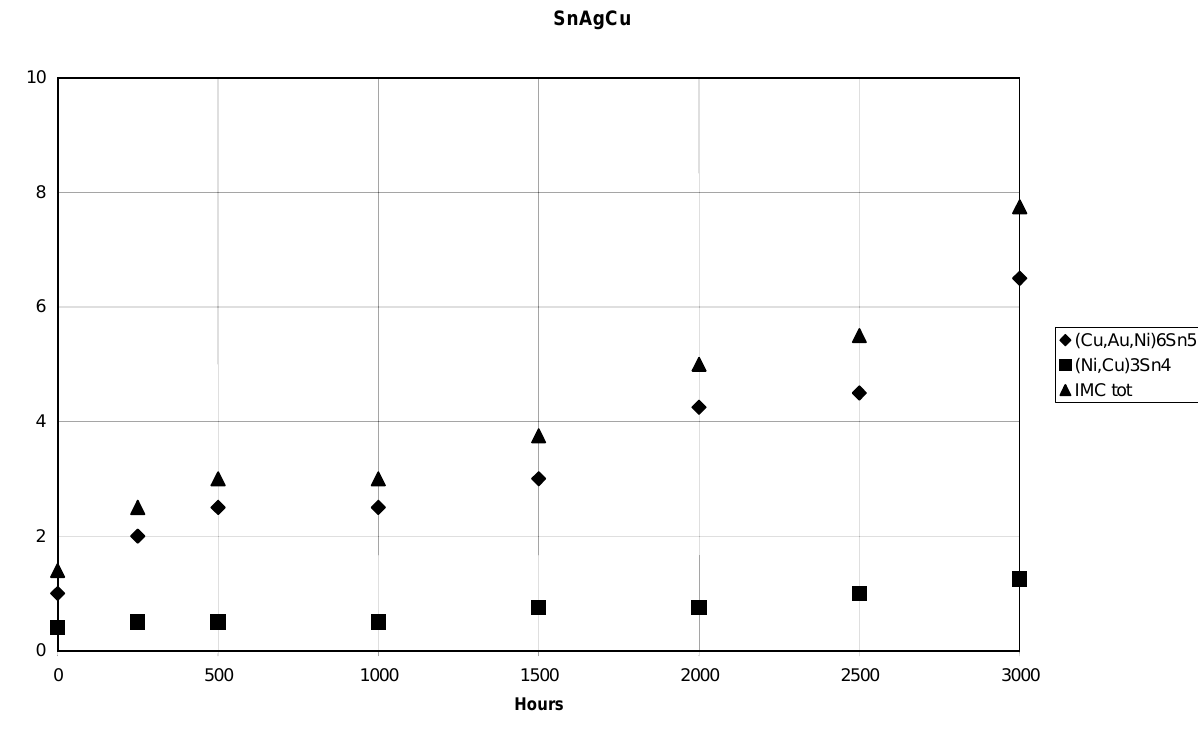
), maximum ( d ) and average thickness ( d min max